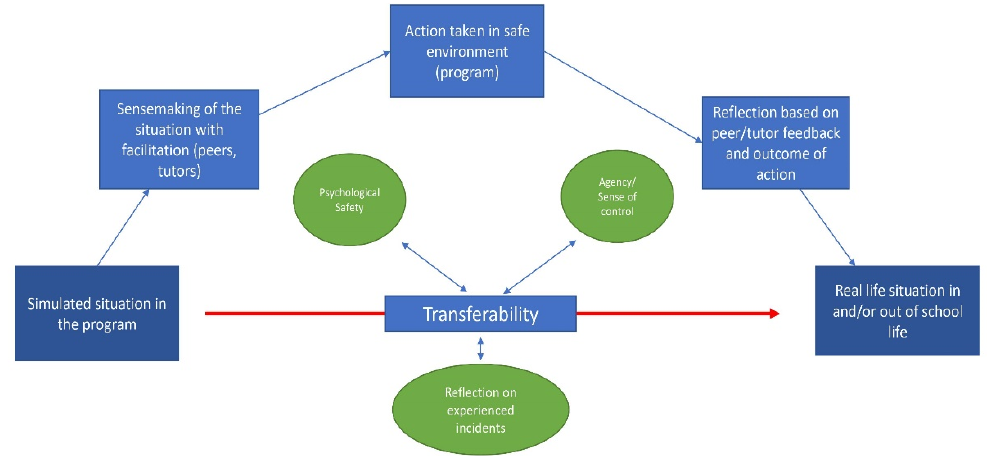
Figure 1. Graphical depiction of the analysis of memorable incidents.